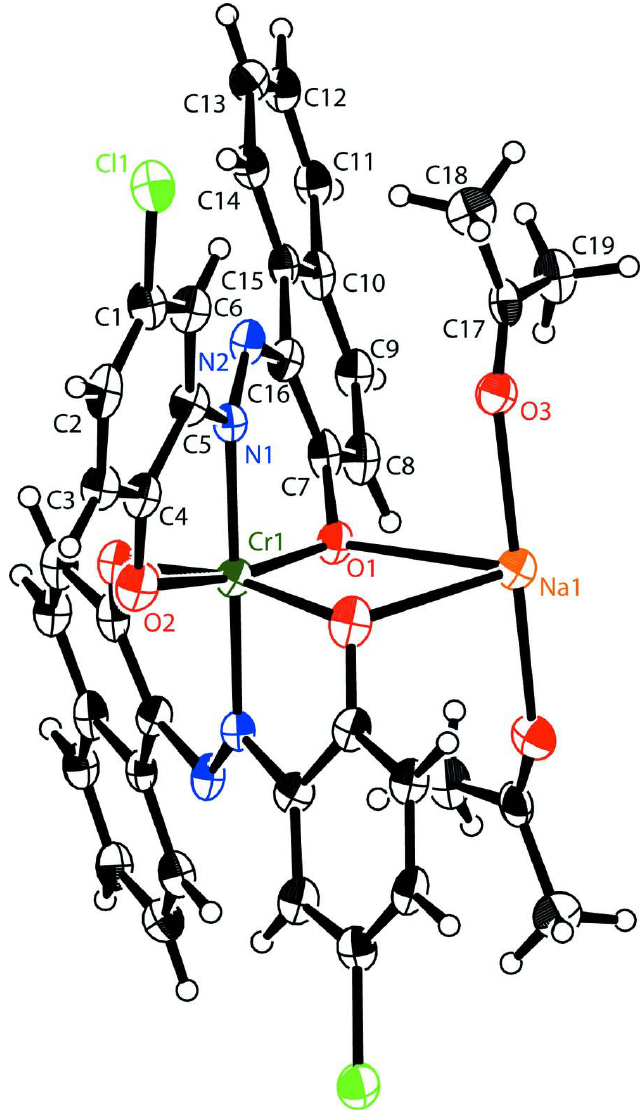
Figure 1 A view of the monomeric structure of the title compound, showing 50% displacement ellipsoids. Unlabelled atoms except for C17—C19 and O3 are related to labelled atoms by the symmetry operation ( x , 1/2 - y , 1/2 - z ), whereas those for C17 —C19 and O3 by the symmetry operation ( x , 1/2 - y , -1/2 - z